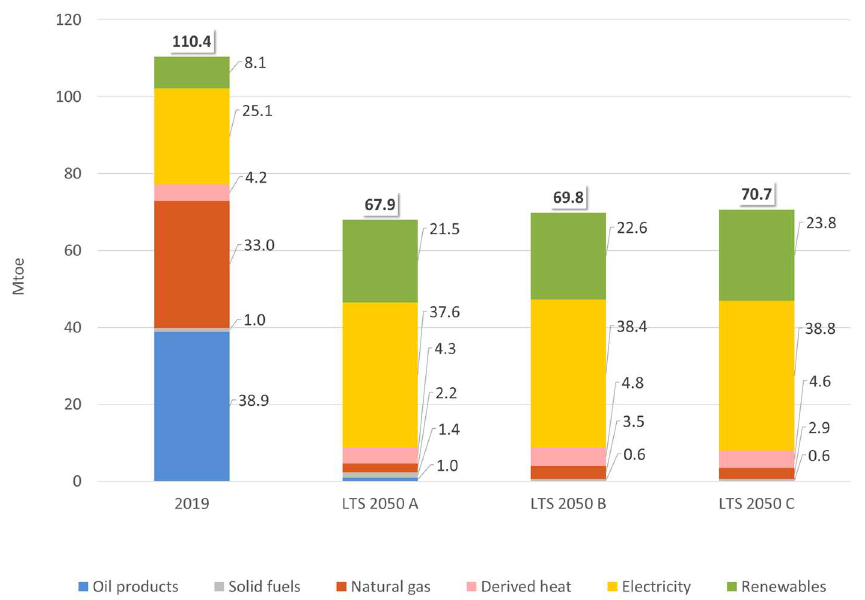
Figure 7. Evolution of final energy consumption by energy carrier: comparison between the current state (2019) and the decarbonization scenarios.